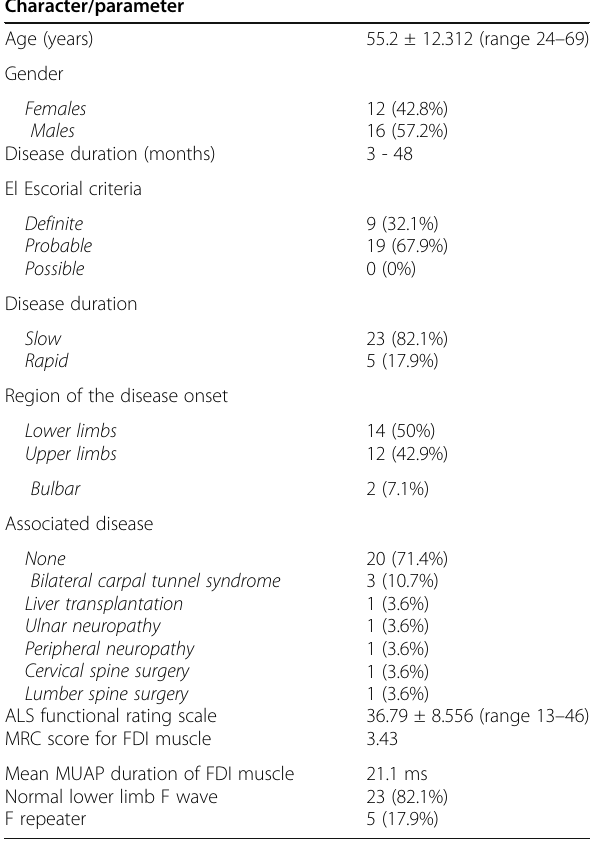
Table 1 The characteristics and clinical data of the patients Character/parameter